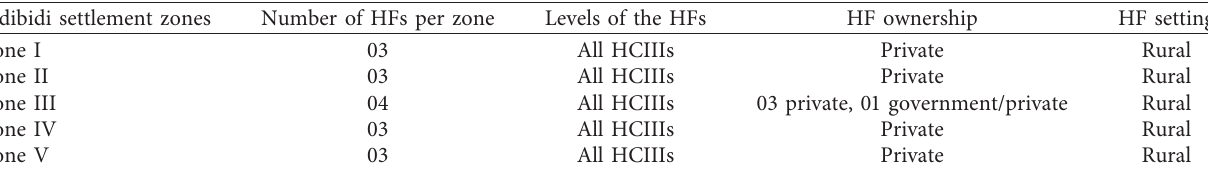
Table 2: Readiness of the health facilities.